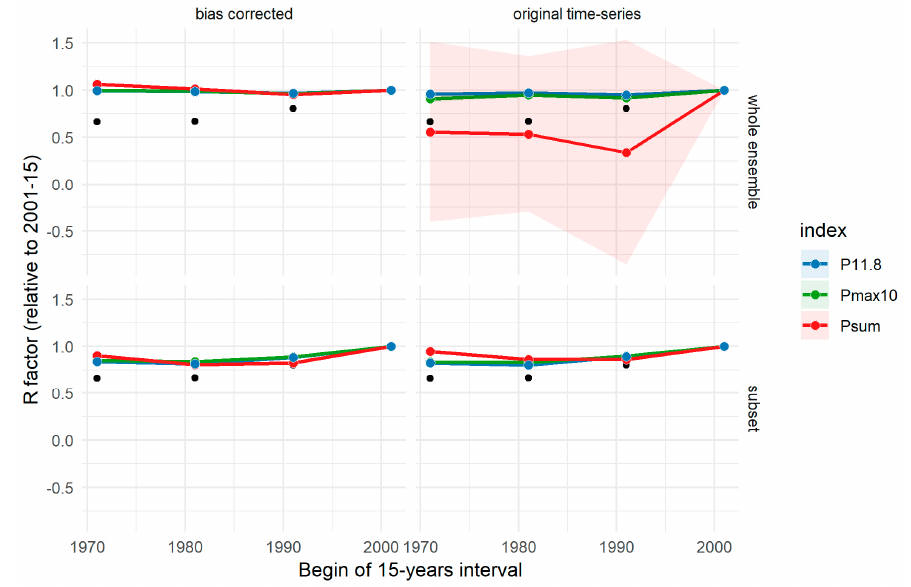
Figure 5. Historical R factors estimated with Equations (1)–(3), different ensembles of climate models (colored lines with 95%-confidence interval of the mean of climate models and stations) and the REGNIE data as reference (black); values relative to the reference period 2001–15. Note: Both RCP and the three REGNIE results were averaged to improve readability.